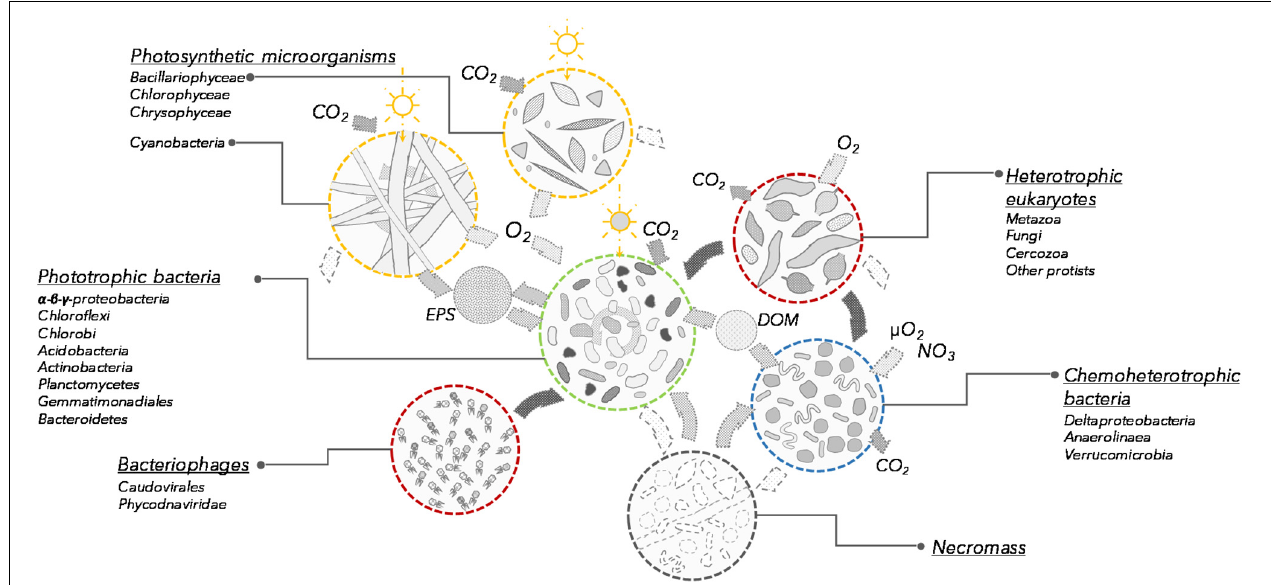
FIGURE 5 | Conceptual model of the communities and processes involved in microbial mat functioning (not to scale). Each group is characterized by its potential function in the microbial mat ecosystem. Open sun indicates photosynthesis and dark sun indicates bacteriochlorophyll and bacteriorhodopsin phototrophy. EPS, exopolysaccharides; DOM, dissolved organic